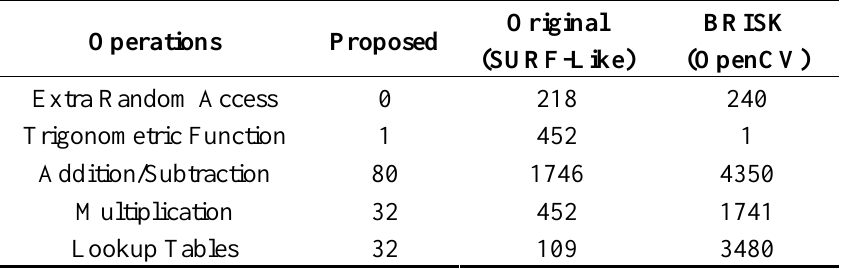
Table 1. Comparison of operations to estimate main